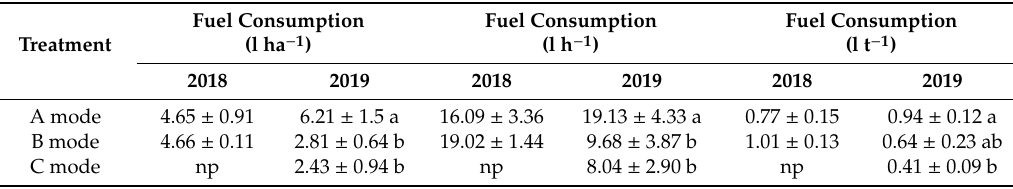
Table 5. Baler fuel consumption in 2018 and 2019 according to treatments (common letters within columns denote the absence of significant di ff erences (p < 0.05)).